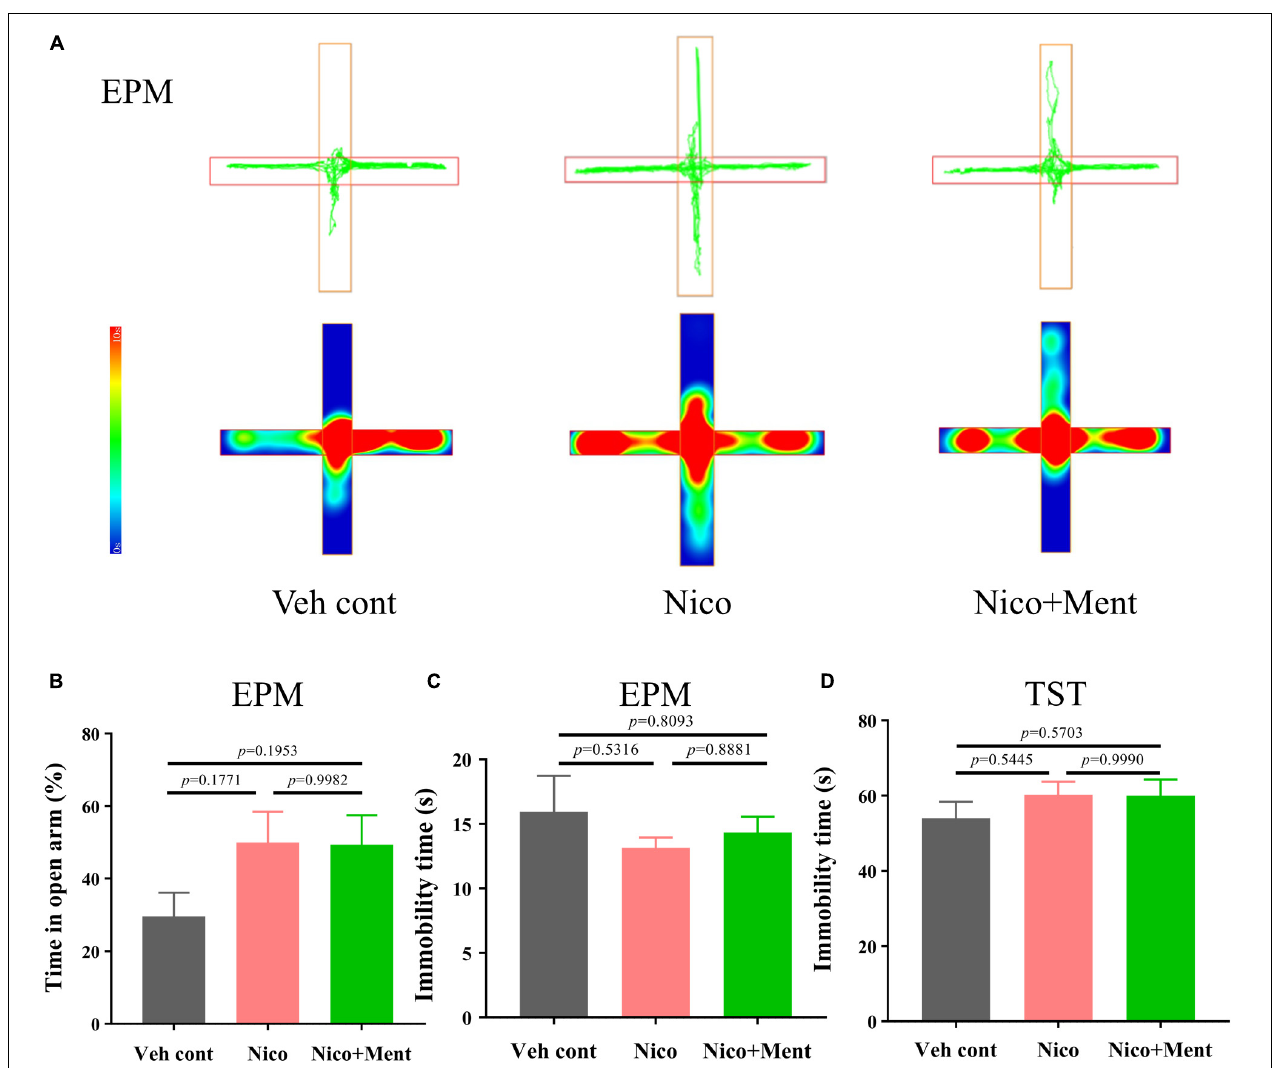
FIGURE 4 | Anxiety, depressive-like behavioral assessments in mice exposed to long-term vapor exposure. (A) The trajectory and heatmap of mice in the EPM. (B) The percentage of time of staying in the open arm to the time of one trial ratio (%) [ F ( 2 , 21 ) = 2.222, p = 0.1333]. (C) The immobility time of mice during the trial in EPM (s). (D) Immobility time of mice during Tail suspension test (s). The value of * p < 0.05 as determined by ordinary one-way ANOVA and multiple comparisons with every other group. Bars represent marginal means ± SEM. N = 8 per group. Veh cont, Vehicle control; Nico, Nicotine; Nico + ment: nicotine with menthol flavor. EPM, Elevated plus maze. TST, Tail suspension